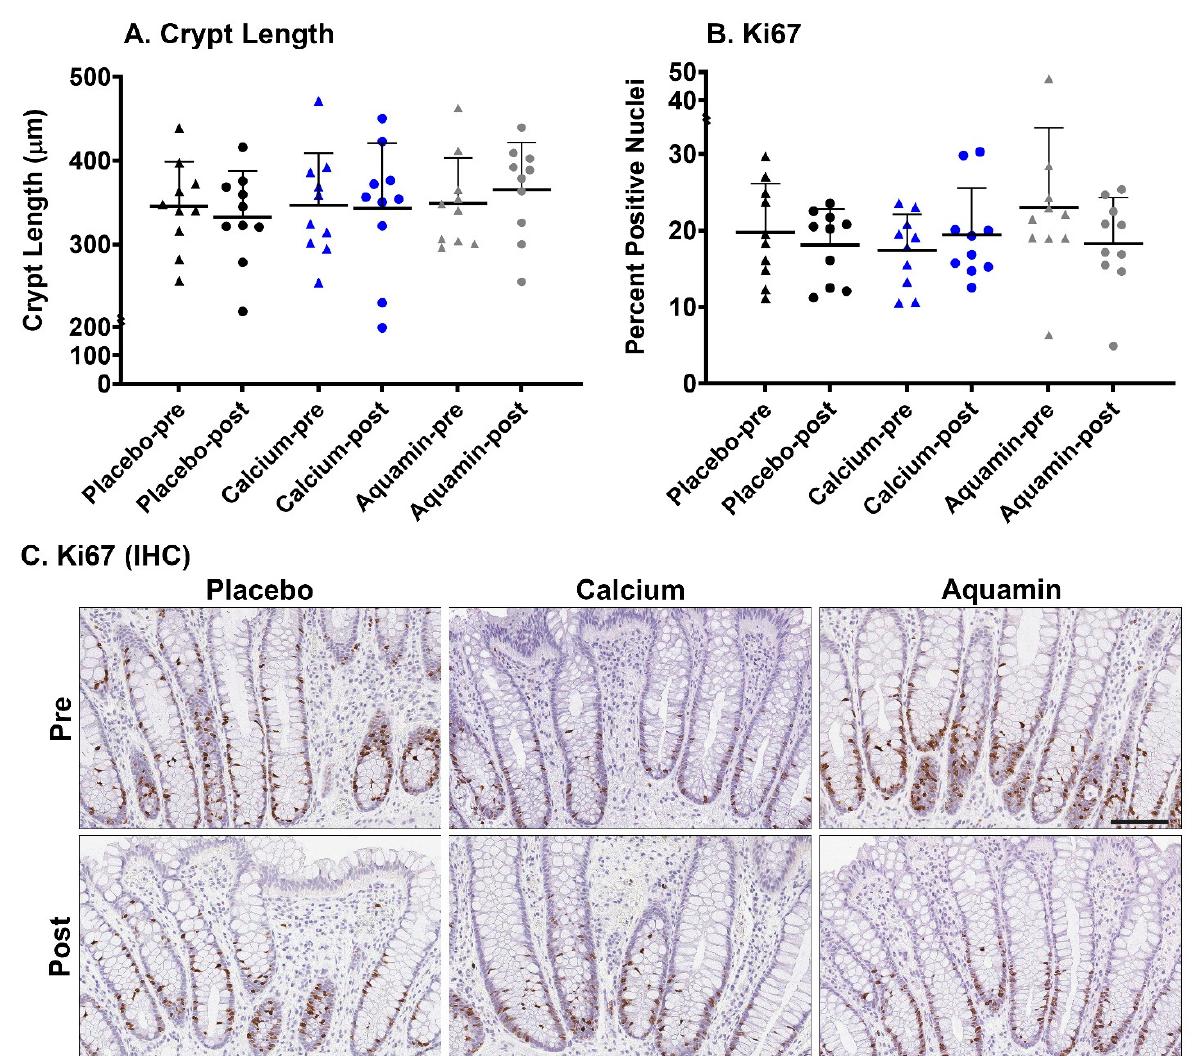
Figure 1. Histological features of the colonic mucosa and proliferation expression. ( A ): Crypt Length. Values represent means and standard deviations based on measurement of crypt length in individual crypts in each colon biopsy (P:70 and 85, CA:2 and 71, AQ:74 and 96–number of pre and post crypts, respectively) per treatment group (10 subjects per group before and after treatment). ( B ): Ki67 expression quantitation. Percentage of Ki67-positive nuclei is presented in each group. Values represent means and standard deviations based on evaluation of individual crypts in each colon biopsy (P:106 and 81, CA:63 and 65, AQ:102 and 82–number of pre and post crypts respectively) per treatment group (10 subjects per group before and after 90-day intervention). Each dot represents an individual subject (A and B). ( C ): Histological appearance and Ki67-stained histological images of the colonic mucosa from a representative subject in each treatment group before and after the 90-day intervention. Scale bar = 100 μ m.